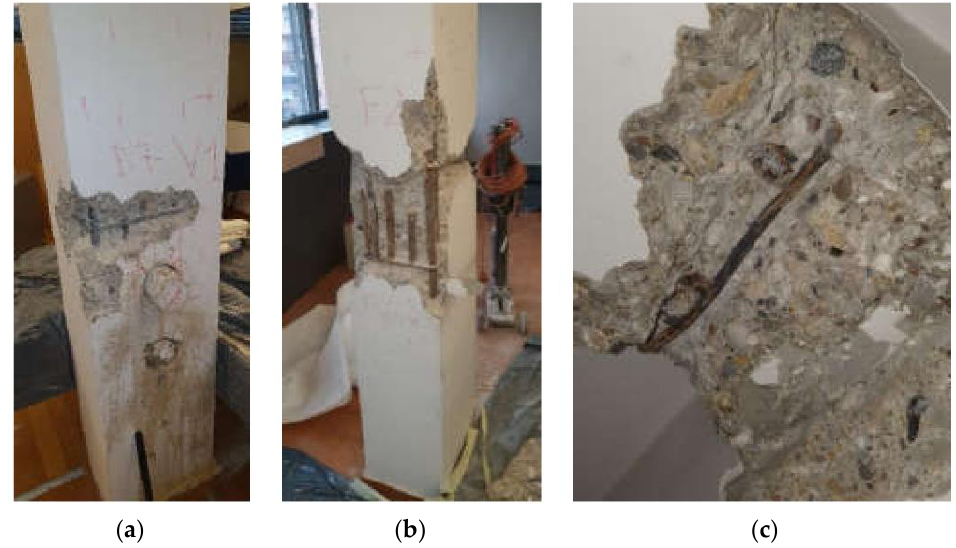
Figure 13. Column on the ground floor ( a ), second floor ( b ), and a beam on the 2nd floor ( c ).